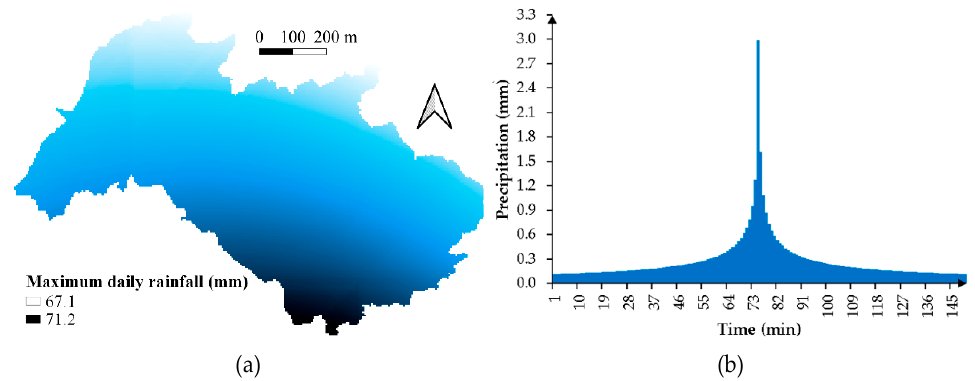
Figure 3. (a) Maximum daily rainfall (mm) obtained through spatial interpolation. (b) Design hyet- Figure 3. ( a ) Maximum daily rainfall (mm) obtained through spatial interpolation. ( b ) Design ograph for the study catchment. hyetograph for the study